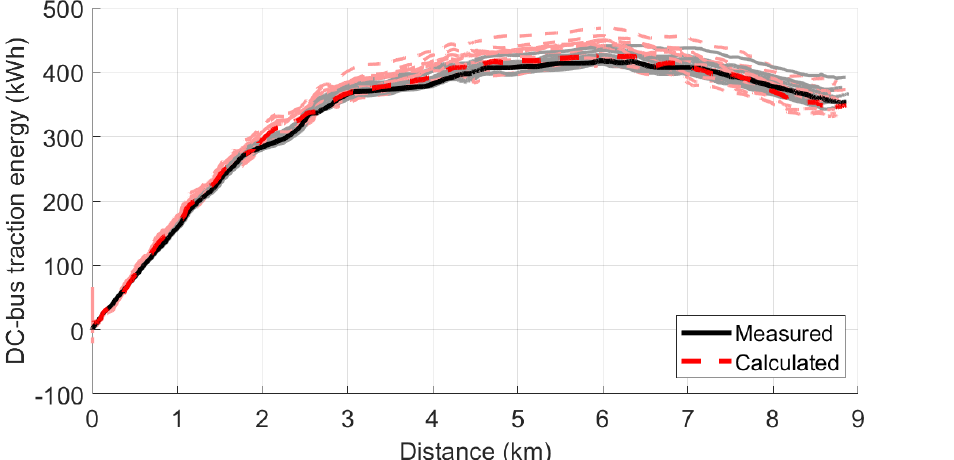
Figure 7. A comparison of measured and modeled energy consumption, at the DC-bus, during the 13 drive-cycles used in the model calibration. One drive cycle has been highlighted for